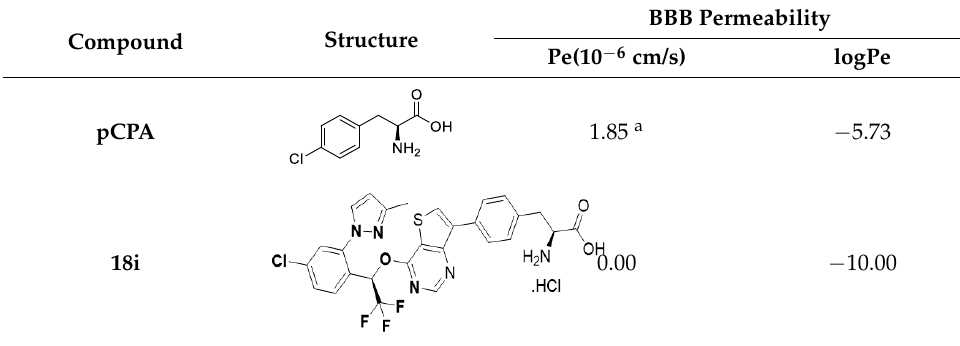
Table 4. PAMPA results.